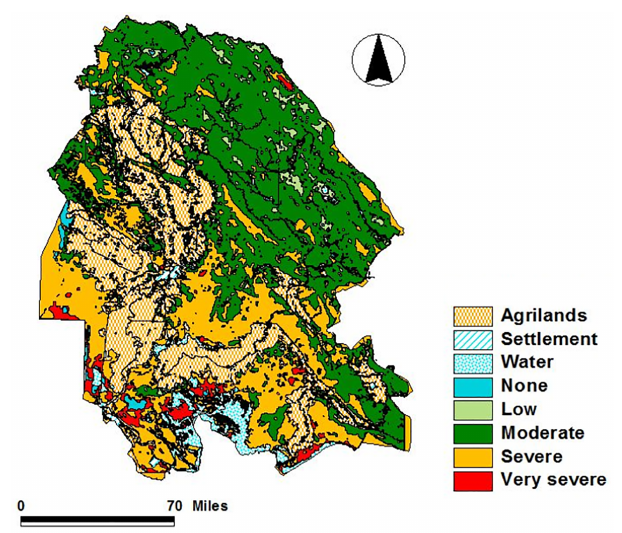
Figure 4. Map of the current state of desertification in the study area.